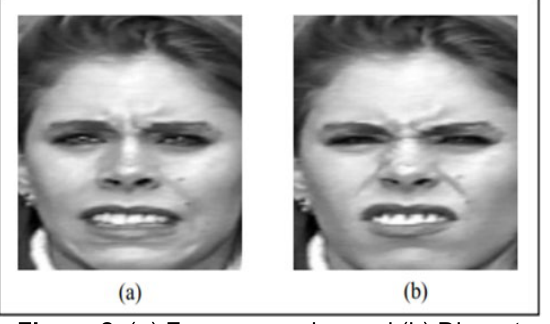
Figure 2. (a) Fear expression and (b) Disgust Expression